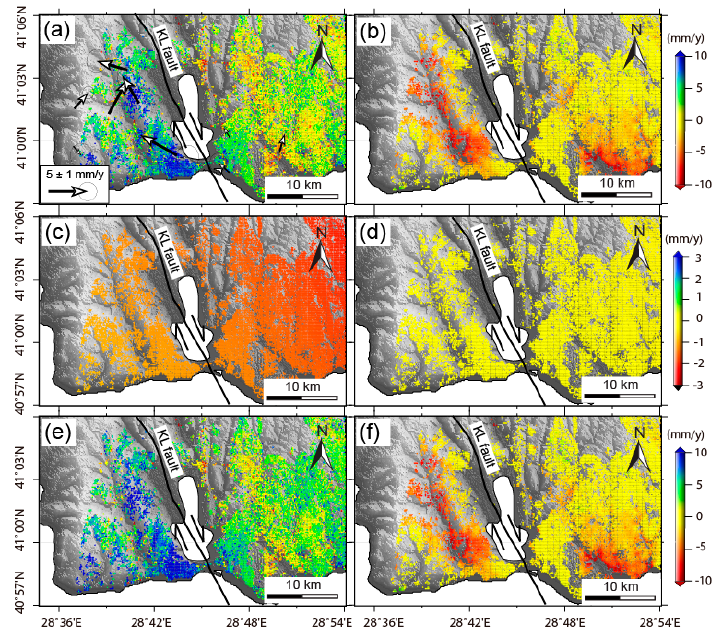
Figure 4. Decomposed InSAR velocity in the horizontal (positive means that points move along N30°W) ( a ) and the vertical direction ( b ); ( c , d ) are the horizontal (N30°W) and vertical crustal velocity that was induced by the post-seismic viscoelastic relaxation of the 1999 İ zmit/Düzce earthquakes; ( e , f ) are fault-parallel and vertical velocity after removing the post-seismic viscoelastic relaxation effect of the İ zmit/Düzce earthquakes; black arrows in ( a ) show GPS velocity in this area [37].